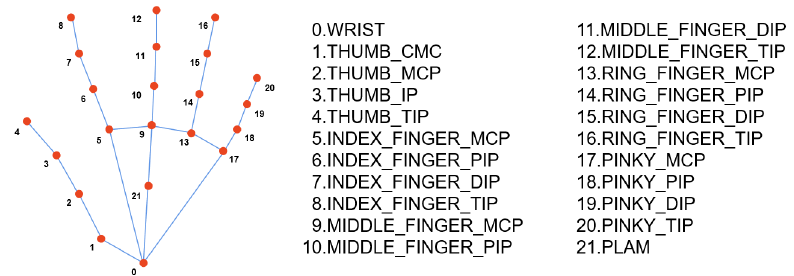
Figure 4. Diagram of hand joint